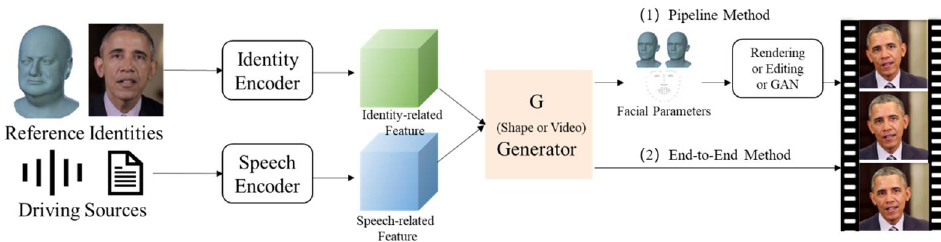
Figure2. Classification of talking-head video generation methods. Figure 2. Classification of talking-head video generation